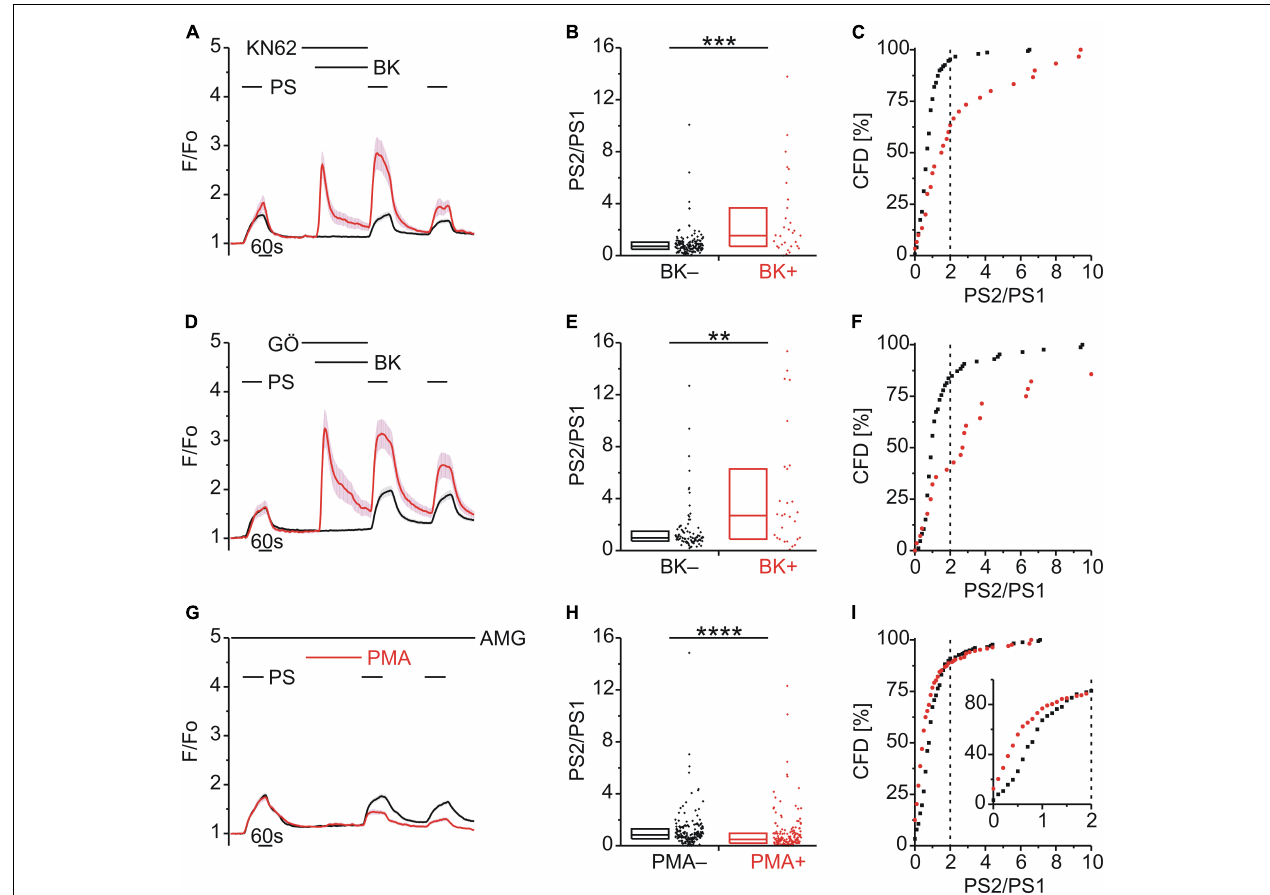
FIGURE 4 | BK-induced TRPM3 sensitization does not involve CaMKII or PKC. (A–C) Calcium signals from DRG neurons (A) during repeat application of pregnenolone sulfate (PS; 40 µ M) with bradykinin (BK; 0.5 µ M) applied between PS1 and PS2 in the presence of the CaMKII inhibitor KN62 (1 µ M). Cells that showed an increase in calcium to BK are indicated in red (BK+; A–C ; 30 neurons) and those that did not in black (BK–; A–C ; 150 neurons). PS2/PS1 ratios are shown as a simple distribution ( B , boxes indicate quartiles and centerline median) and cumulative frequency distribution ( C ; CFD). Each dot-like symbol in (B,C) represents the ratio value calculated for a single, individual cell. Values derive from three measurements with cells from one mouse. (D–F) Calcium signals from DRG neurons (D) during repeat application of PS with BK applied between PS1 and PS2 in the presence of the PKC inhibitor Gö6983 (GÖ; 1 µ M). BK+ cells are indicated in red ( D–F ; 28 neurons) and BK– in black ( D–F ; 86 neurons). PS2/PS1 ratios are shown as a simple distribution (E) and CFD (F) . Values derive from three measurements with cells from one mouse. (G–I) Calcium signals from DRG neurons (G) during repeat application of PS either with or without the PKC activator phorbol-12-myristate-13-acetate (PMA; 1 µ M) applied between PS1 and PS2 and all the while in the presence of the TRPV1 inhibitor AMG9810 (AMG; 4 µ M). Cells that were treated with PMA (PMA+; 168 neurons) are indicated in red and those untreated with PMA (PMA–; 178 neurons) are shown in black. PS2/PS1 ratios are shown as a simple distribution (H) and CFD (I) . The inset in (I) illustrates a zoomed in segment of the CFD for ratio values between 0 and 2. One ratio value (“34.78”) of the PMA+ group was not shown in (H) for better visibility, but was included in the analysis. Values derive from eight measurements with cells from two mice. BK+ and BK– as well as PMA+ and PMA– groups (B,E,H) were compared with Mann-Whitney U -tests. ** P < 0.01, *** P < 0.001, **** P <